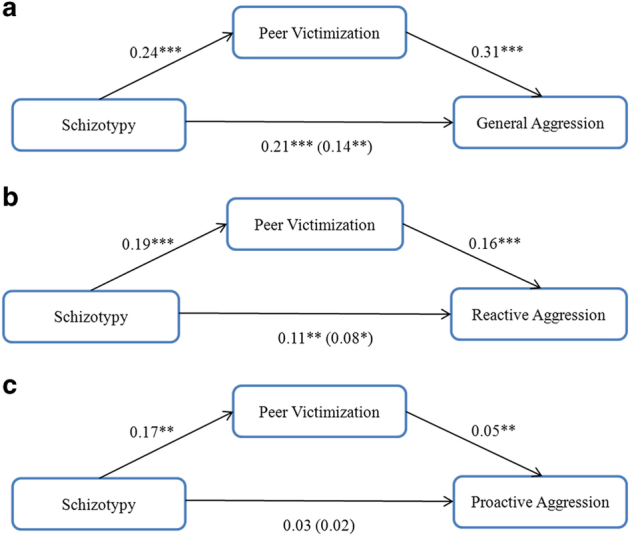
The mediation between schizotypy, peer victimization and (a) general aggression (mean indirect effect=0.071, 95% CI=0.0326, 0.1291), (b) reactive aggression (mean indirect effect=0.03, 95% CI=0.0096, 0.0637), and (c) proactive aggression (mean indirect effect=0.01, 95% CI=0.0005, 0.0238) after controlling for age, sex, education and employment status (coefficient in parenthesis in the figure indicated the direct effect after mediated by peer victimization). *P⩽0.05, **P⩽0.01, ***P⩽0.001. CI, confidece interval.